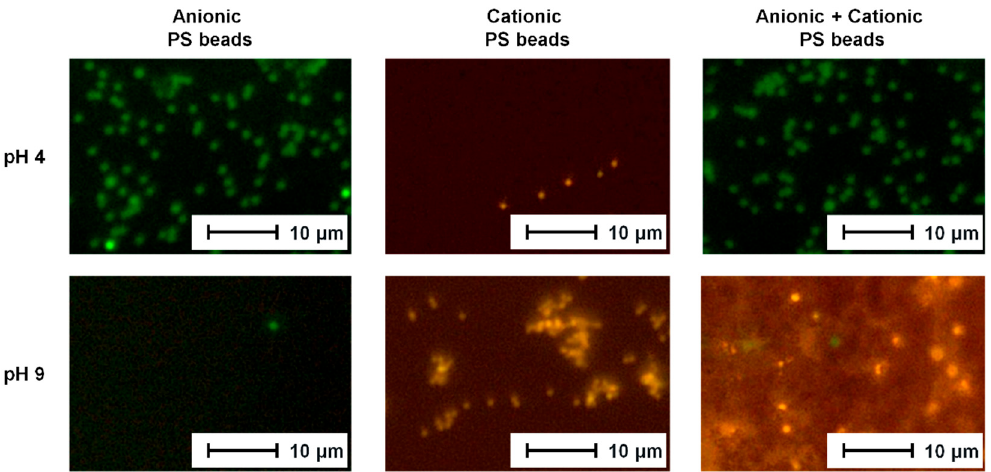
Figure 4. Fluorescence microscopy images of PS beads (anionic/cationic/mixture) adsorbed to the PES–Lysine membrane at pH 4 and pH 9, respectively.